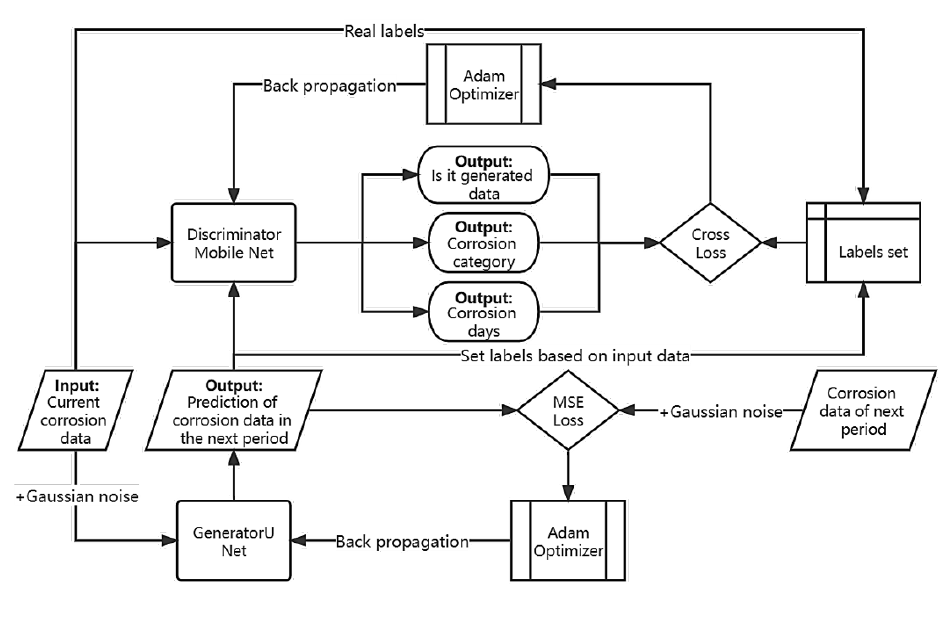
Figure 6. System